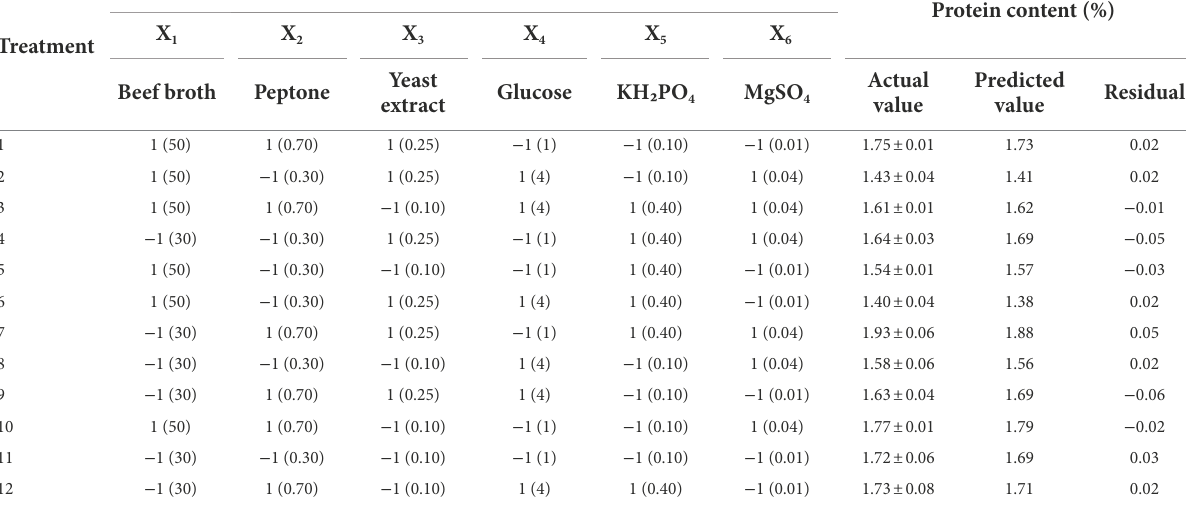
TABLE 1 Plackett-Burman experimental design matrix for screening composition of the growth medium.